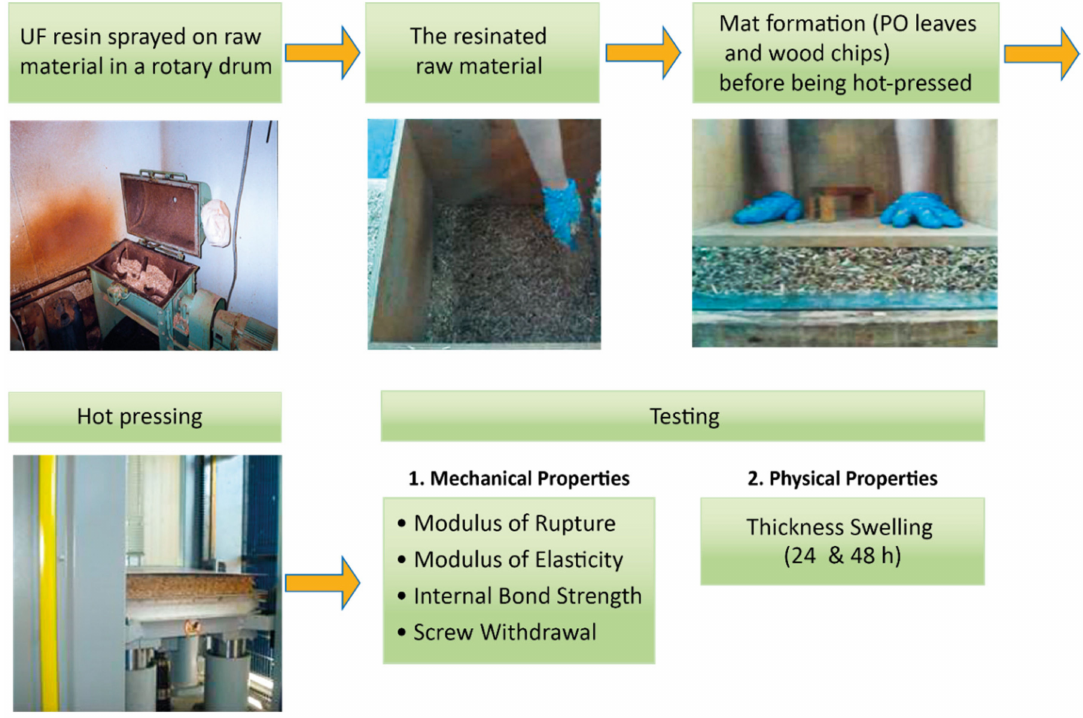
Figure 2. The flow diagram of the experimental